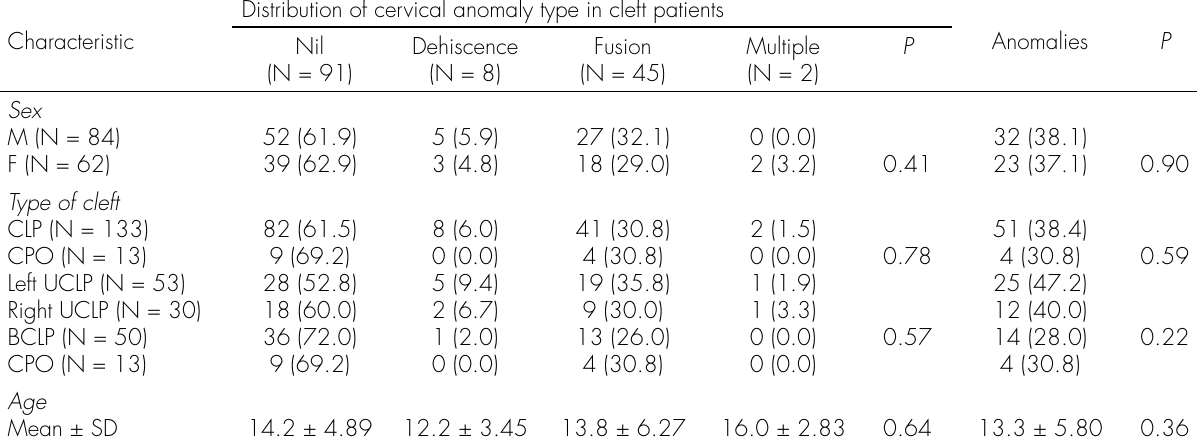
Table III. Comparison of cervical vertebrae anomalies in patients with CLP and